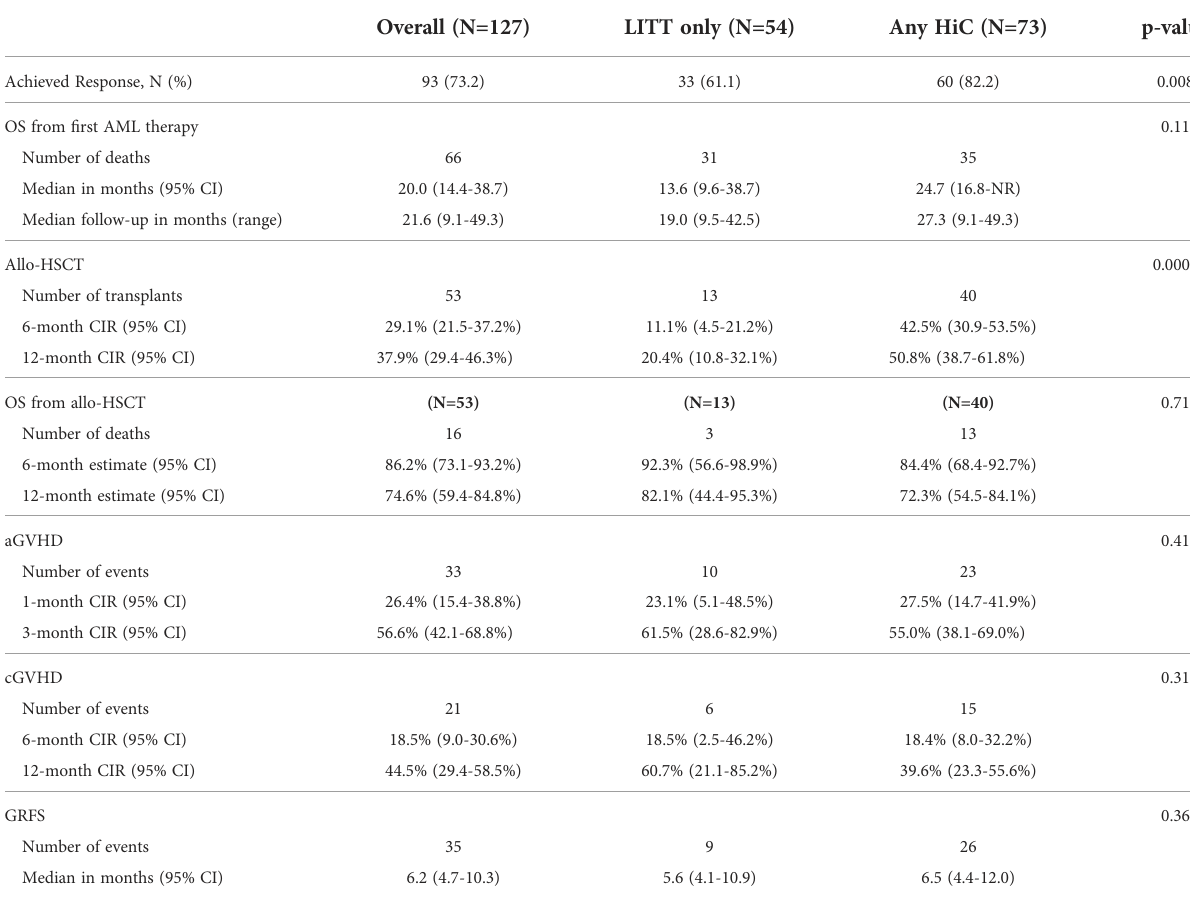
TABLE 2 Clinical outcomes according to treatment